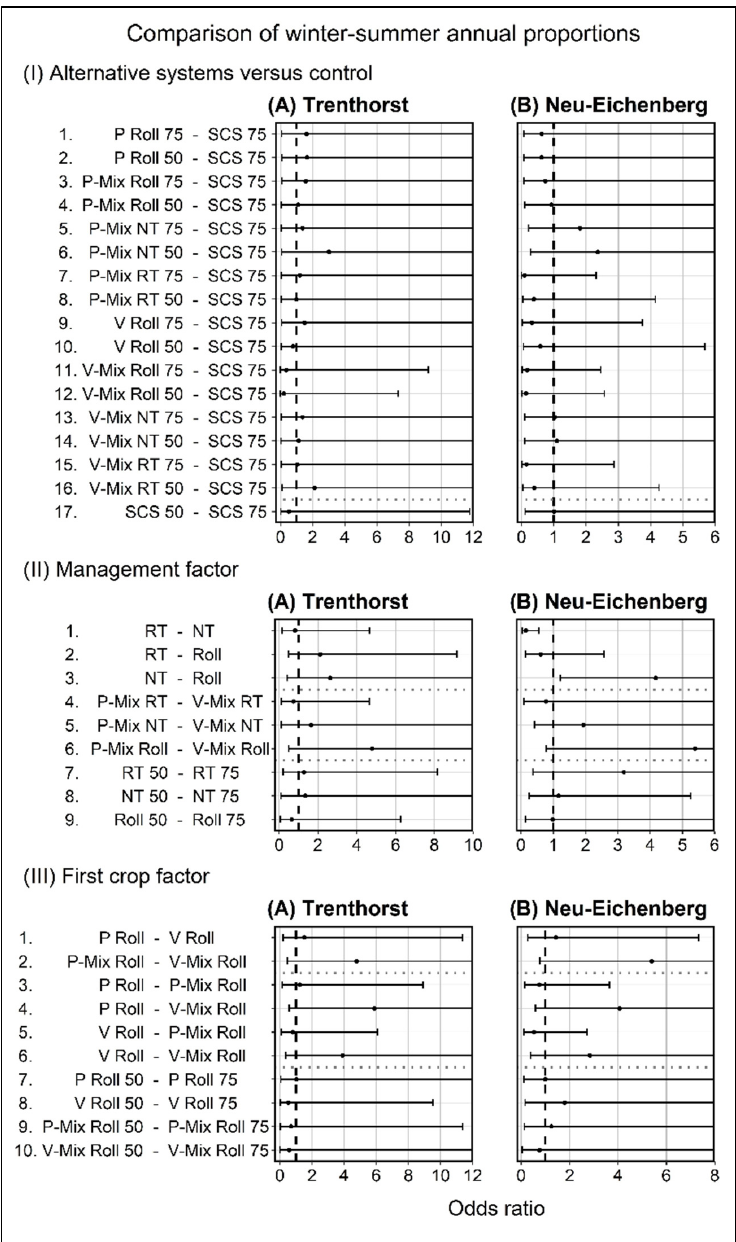
Figure A2. Comparison of winter-summer annuals averaged over year at the two locations with the foci: ( I ) Alternative systems versus control, ( II ) Management factor and ( III ) First crop factor. The contrast in question is shown on the y-axis, whereas its scale is on the x-axis. Factor levels for first crop are: P = winter pea, V = hairy vetch, P-Mix and V-Mix = their mixtures with a cereal partner; for management are: SCS = control, RT = reduced tillage, NT = no tillage and Roll = rolling of first crop; and for row width are: 75 cm and 50 cm. Points represent odds ratios for treatment comparisons. The odds ratios were computed using exponential transformation of the linear contrasts of mean estimates on the logit-scale (log-odds scale). The vertical dashed lines at 1 show the H 0 , where the odds ratio of the estimates is 1 (estimated means are equal). Error bars show the 95% CI of the estimated difference after a multivariate t adjustment. Thus, when this crosses the vertical dashed line (H 0 ), there is statistically no or a non-significant difference between means at α = 0.05. Each focus group is analyzed independently. Please note that DCS NT treatments at TRE were only present in the second year and that focus ( I ) were cut in scale for less distortion of the hypothesis testing through inspecting odds ratios compared with the H 0